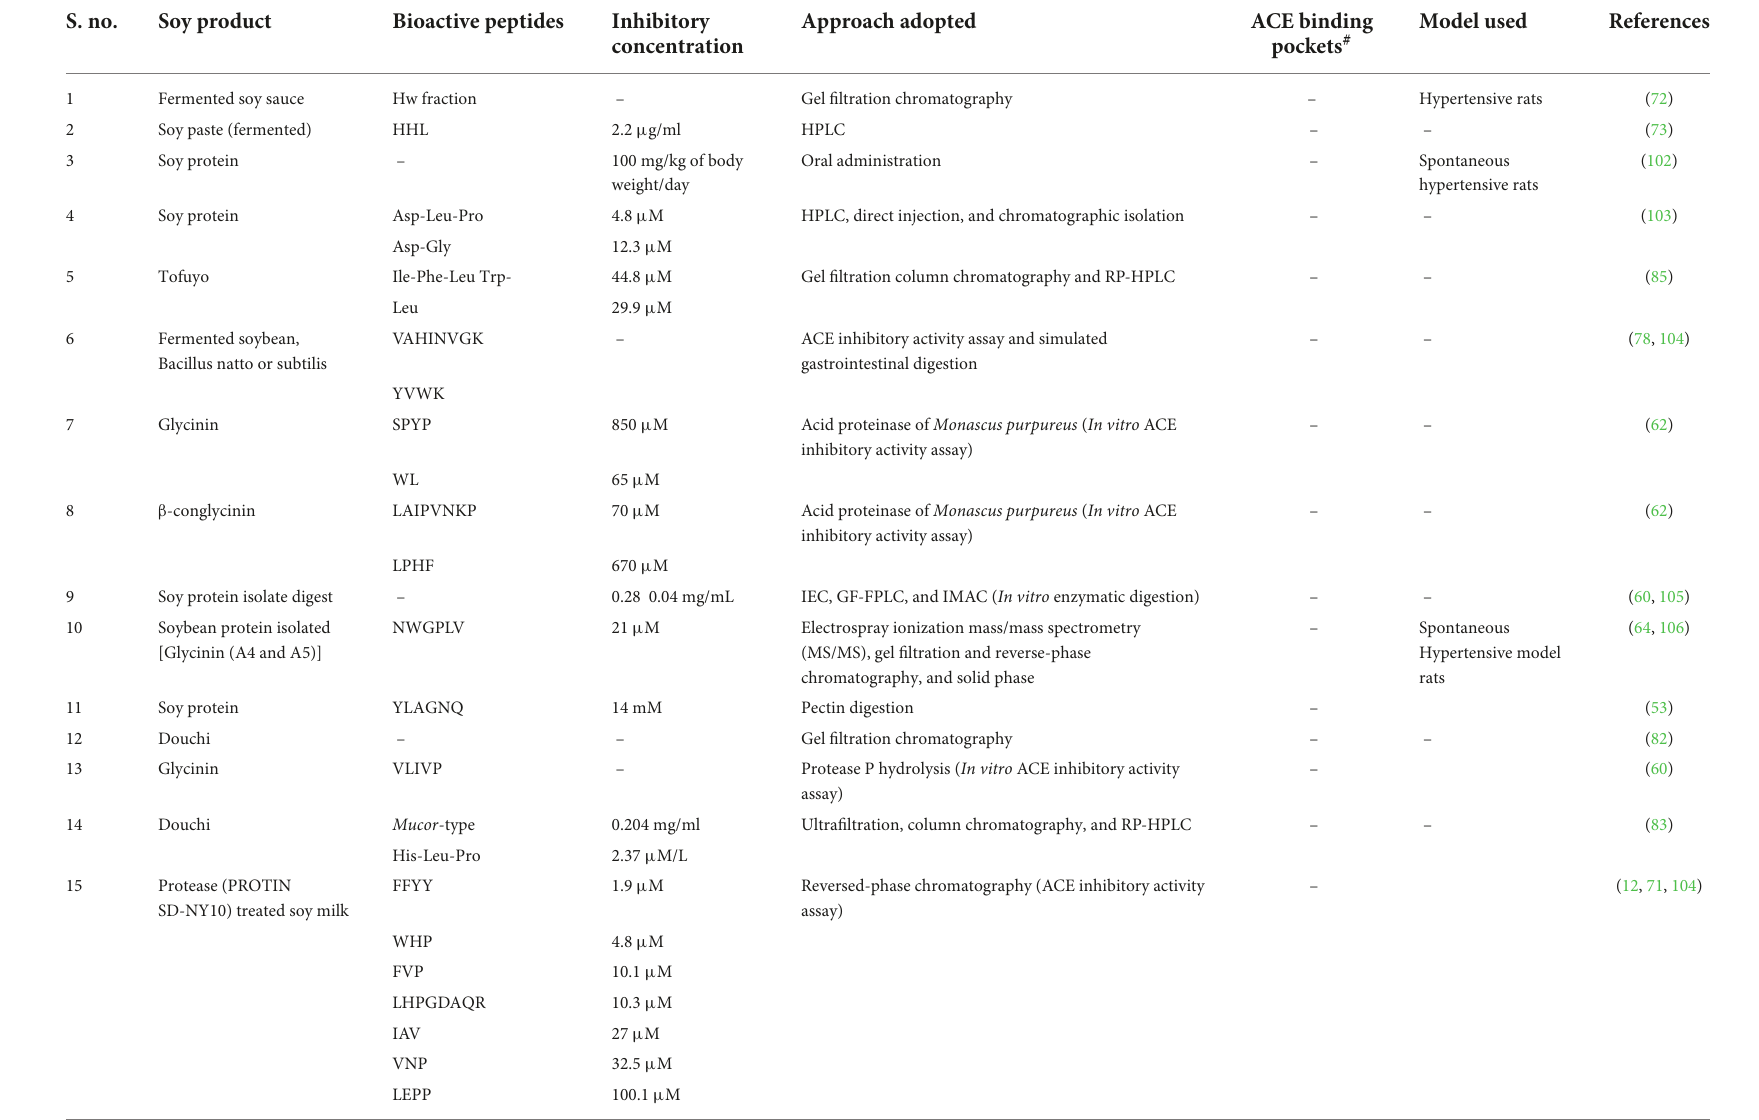
TABLE 1 Summary of inhibitory soybean bioactive peptides with their IC 50 values and interacting ACE subsites. S.